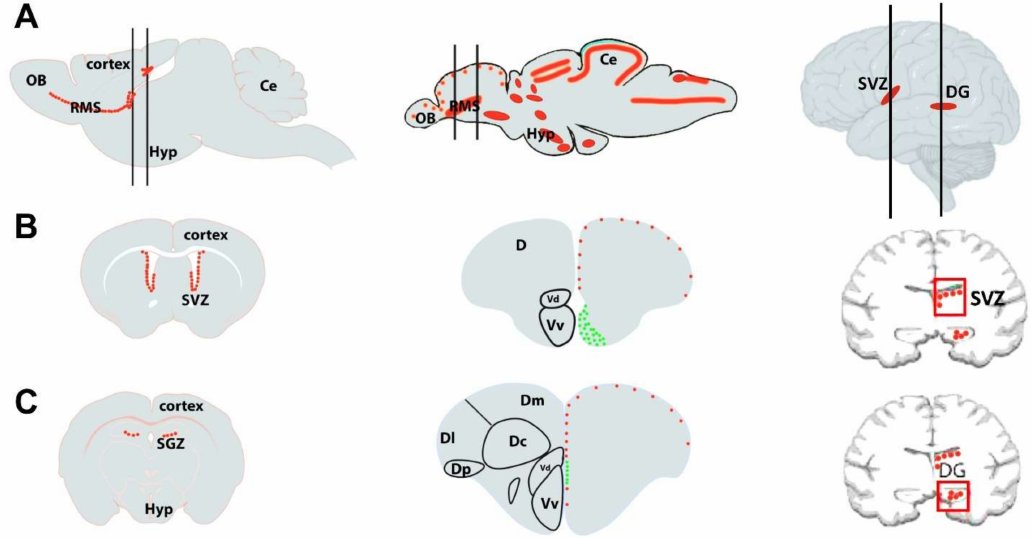
Figure 3. Schematic drawing of ( A ) a sagittal section of rodent (left), zebrafish (middle), and human (right) brains with the main neurogenic niches indicated in red. The mammalian brain displays only two main neurogenic niches: the subventricular zone (SVZ) of the lateral ventricles and subgranular zone (SGZ) of the dentate gyrus (DG) of the hippocampus. The black lines correspond to coronal sections. ( B , C ): Transversal sections through the brain, marking the major neurogenic niches of the respective species shown in A. In zebrafish, the red dots correspond to slow-cycling progenitors (mainly radial glial cells, type 2), and the green ones to fast-cycling progenitors (mainly neuroblasts, type 3). OB, olfactory bulbs; Ce, cerebellum; D, telencephalic dorsal area; Hyp, hypothalamus; RMS, rostral migratory stream; Dm, dorsomedial zone of the dorsal telencephalon; Dc, central zone of the dorsal telencephalon; Dl, lateral zone of the dorsal telencephalon; Dp, posterior zone of the dorsal telencephalon; Vd, dorsal nucleus of the ventral telencephalon; Vv, ventral nucleus of the ventral telencephalon. This figure is adapted from